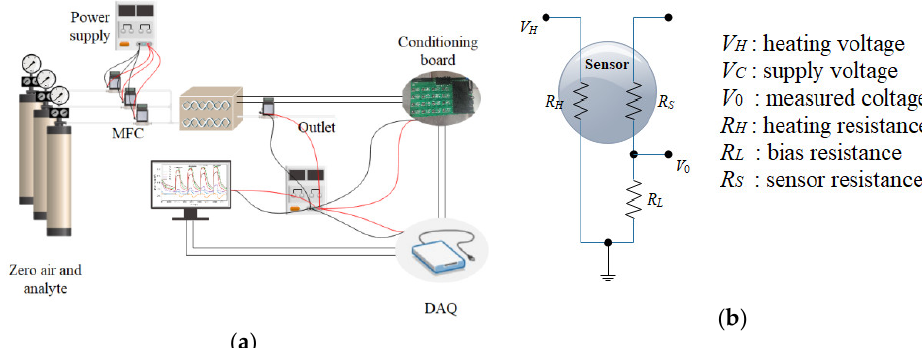
Figure 2. ( a ) The improved system of the EN and the automated test system; ( b ) The measurement